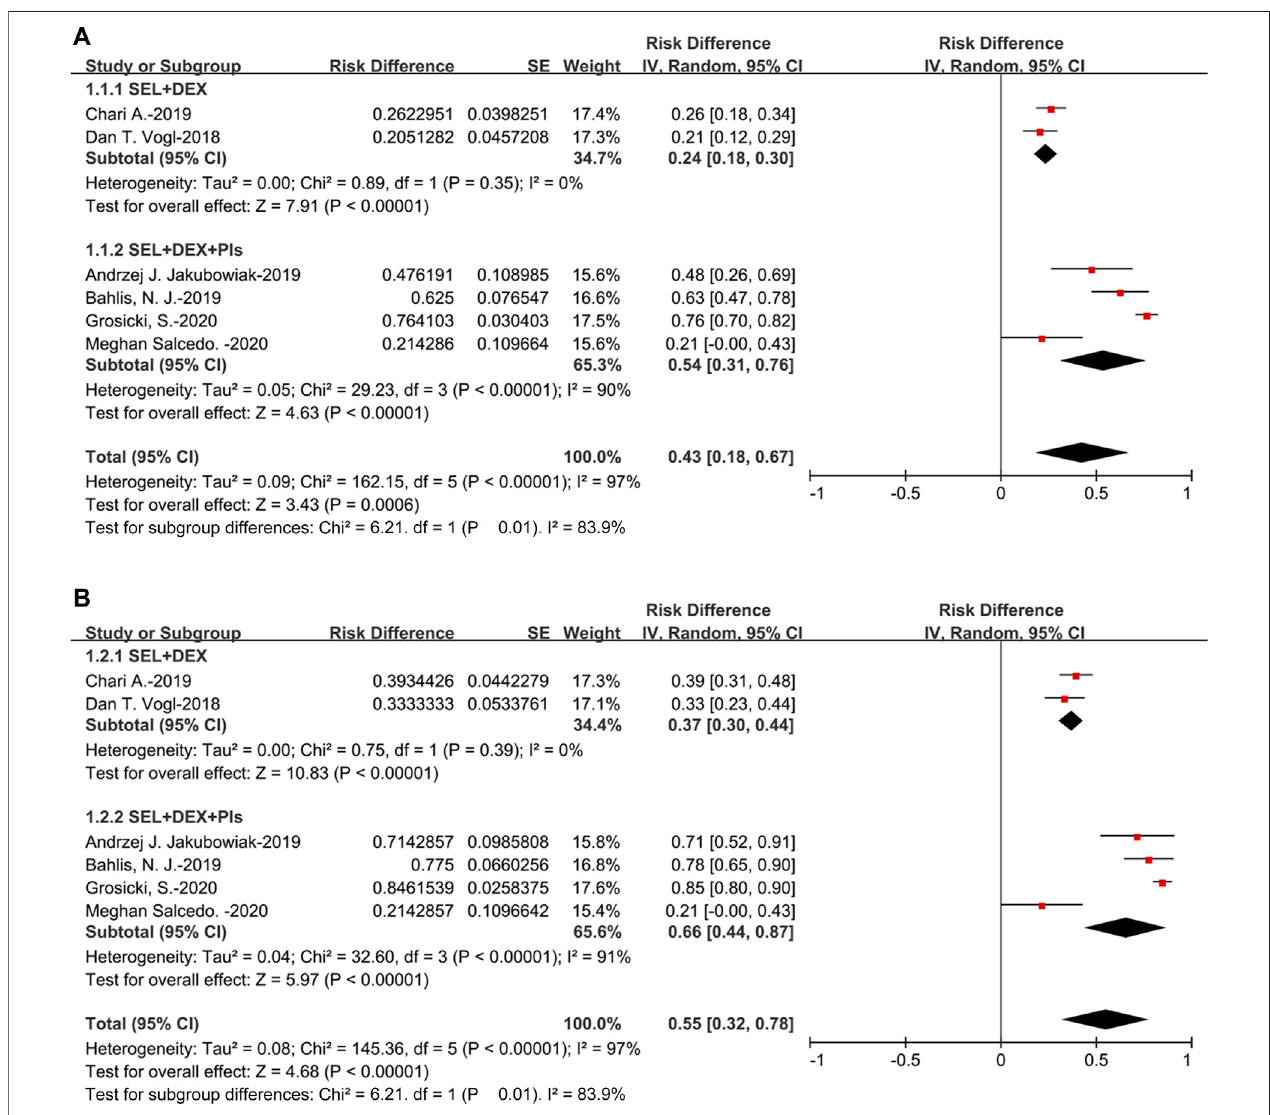
FIGURE 2 | The forest plot of pooled (A) ORR, and (B)